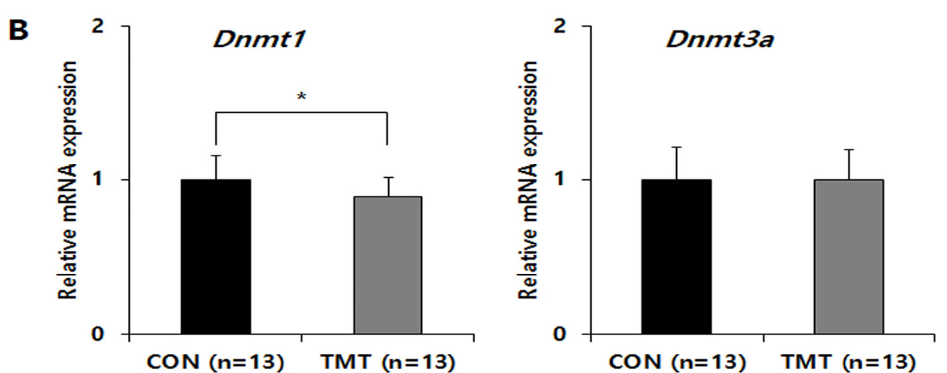
Figure 1. Global DNA methylation and Dnmt gene expression in the hippocampi of mice prenatal exposed to TMT. ( A ) Sex differences in global cytosine methylation and hydroxymethylation in genomic DNA samples of control and TMT groups. ( B ) Relative mRNA expression of Dnmt1 and Dnmt3a , normalized to Gapdh as an internal control in the male hippocampus. * p < 0.05, *** p < 0.001 compared to control (CON). Data are shown as means ± standard deviations (SD).